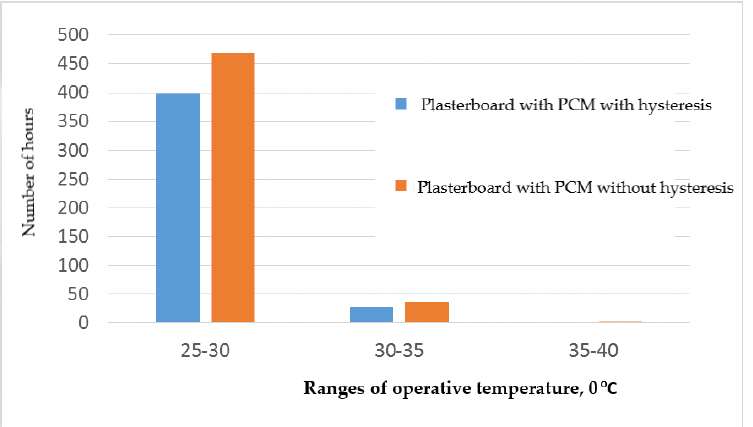
Figure 13. The time of occurrence of the operative temperature in individual ranges in the variant with a plasterboard with PCM